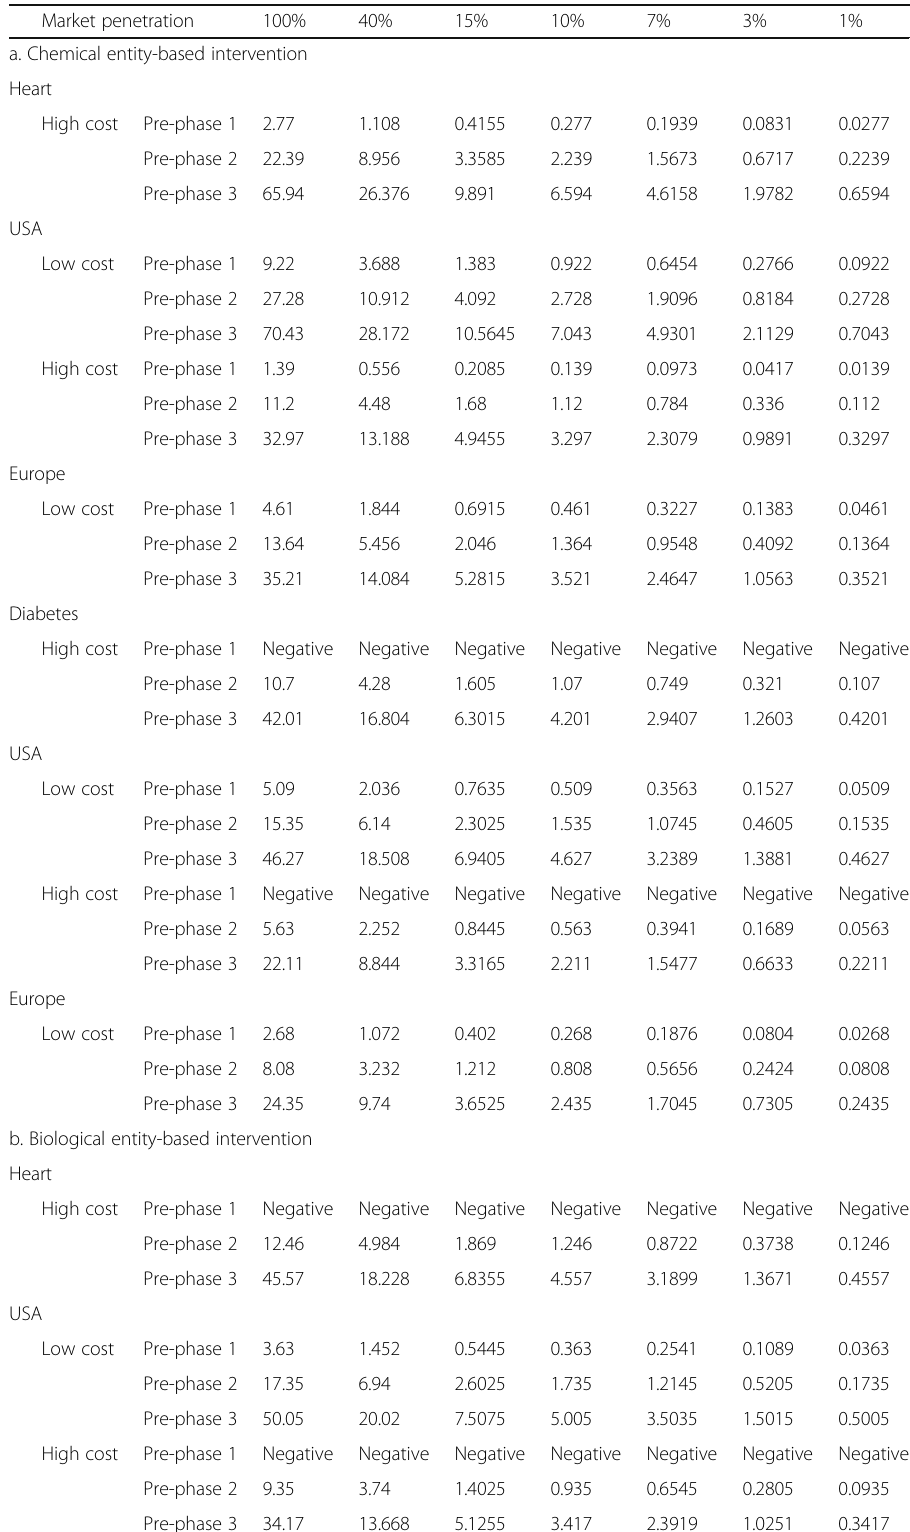
Table 8 SOM rNPVs for each market using real-world data potential market share (numbers in millions of USD) using progress dependent dynamic risk rates (pd-DRR) for